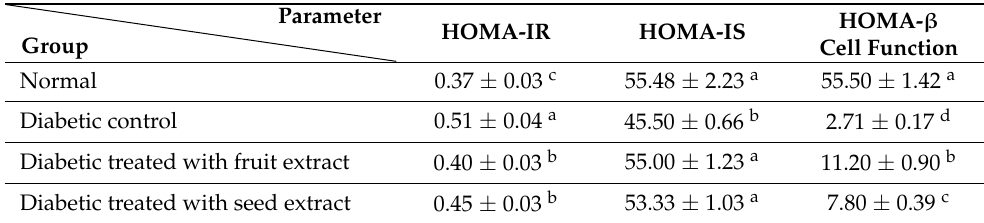
Table 4. Effects of the B . aegyptiaca fruit and seed extracts on HOMA-IR cell function, HOMA-IS, and HOMA- β cell function in NA/STZ-induced diabetic